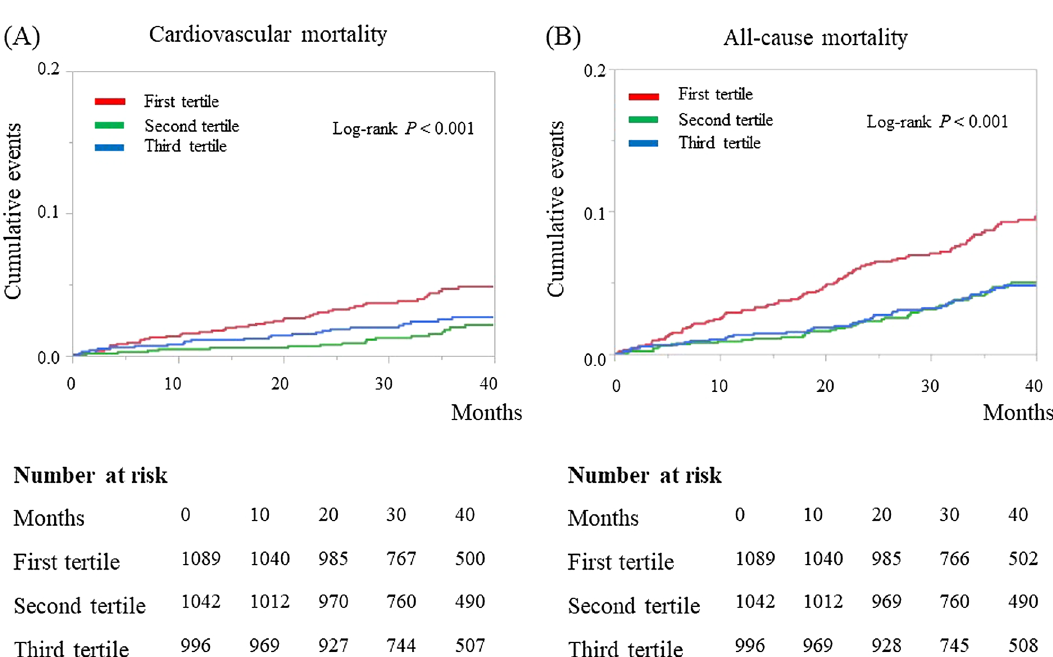
Figure 2. Kaplan–Meier curves for the incidence of cardiovascular mortality ( A ) and all-cause mortality ( B ) during the follow-up period according to the tertiles of baseline alanine aminotransferase values in patients with nonvalvular atrial fibrillation (n = 3156) in the SAKURA AF